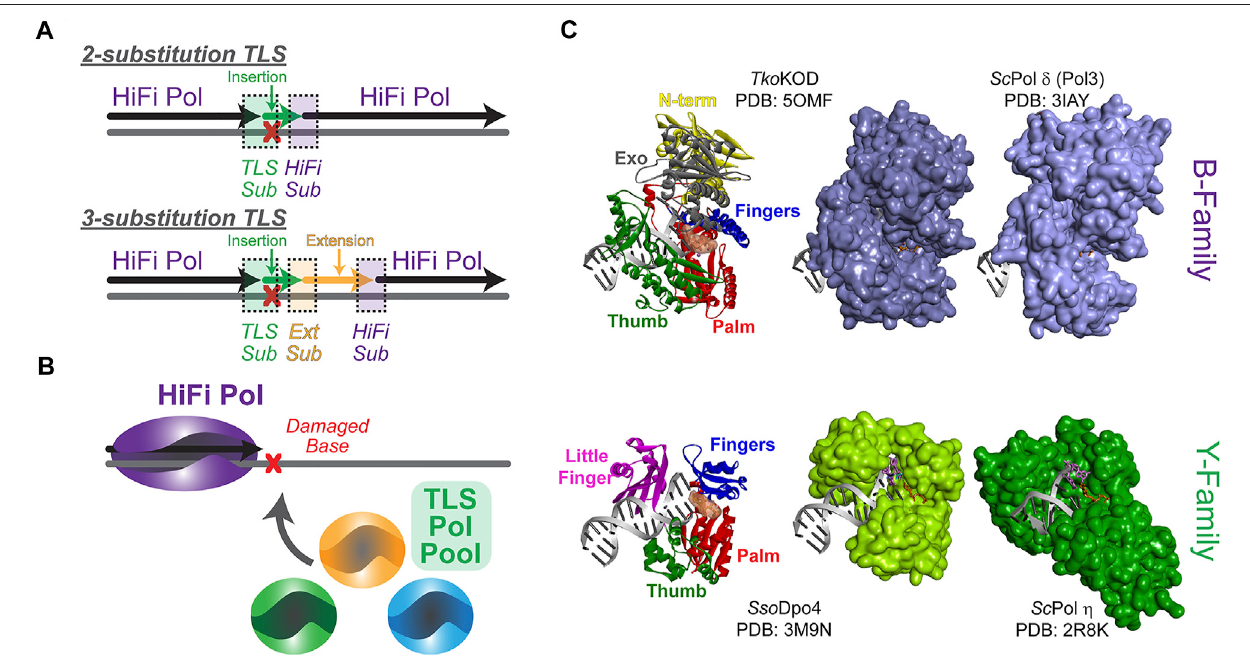
FIGURE 1 | Steps required for the overall translesion synthesis (TLS) process. (A) A high fi delity (HiFi) polymerase (Pol) will stall at a lesion requiring two- or three- substitution TLS for bypass. In a two-substitution mechanism, the fi rst TLS substitution (sub) will recruit an inserter TLS Pol (green) for translesion DNA insertion (green) followed by substitution back to a HiFi Pol (purple). In a three-substitution mechanism, an extender (Ext) TLS Pol is substituted after insertion and is required for limited downstream extension (orange) prior to substitution back to the HiFi Pol. (B) TLS substitution will be in fl uenced by the available TLS Pol Pool as well as the speci fi city for a particular lesion. (C) Compares the polymerase domain structure (N-term — yellow, Exo — grey, Palm — red, Fingers — blue, Thumb — green, and Little Finger — pink) for the more closed structures of HiFi B-family Pols KOD ( Thermococcus kodakarensis ) (Kropp et al., 2017) and Pol δ ( Saccharomyces cerevisiae ) (Swan et al., 2009) with the more open active sites of TLS Y-family Pols Sso Dpo4 (Wong et al., 2010) and Pol η ( Saccharomyces cerevisiae ) (Alt et al., 2007) in complex with DNA, all arranged in the same